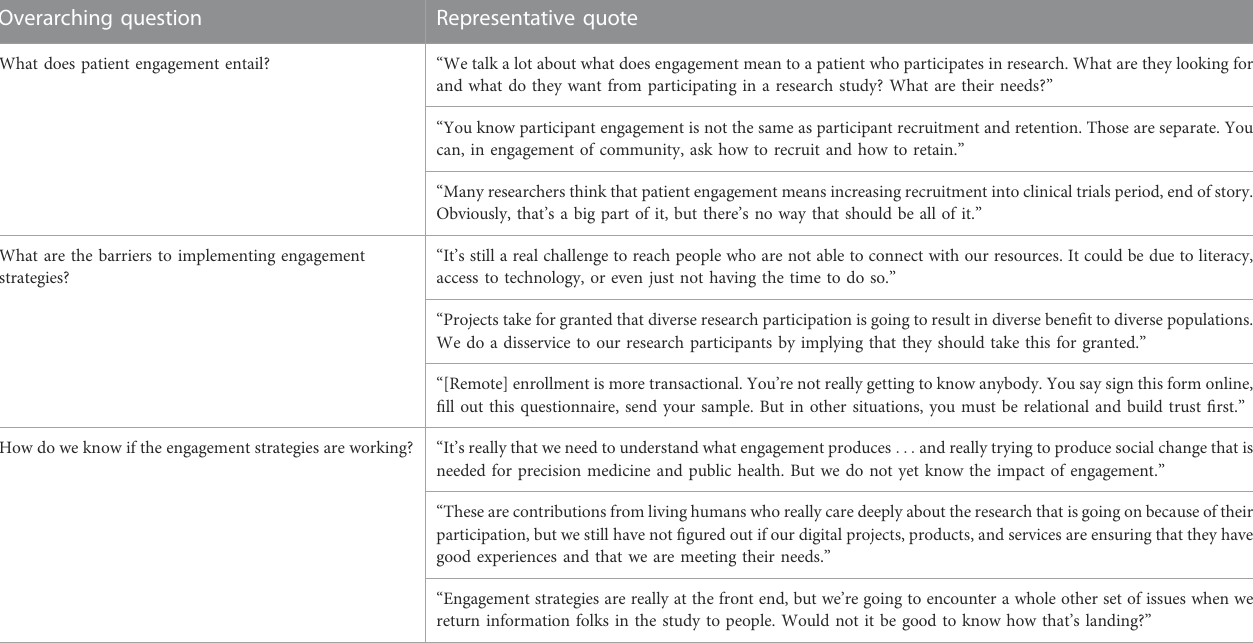
TABLE 3 Overarching questions about current state of engagement. Overarching